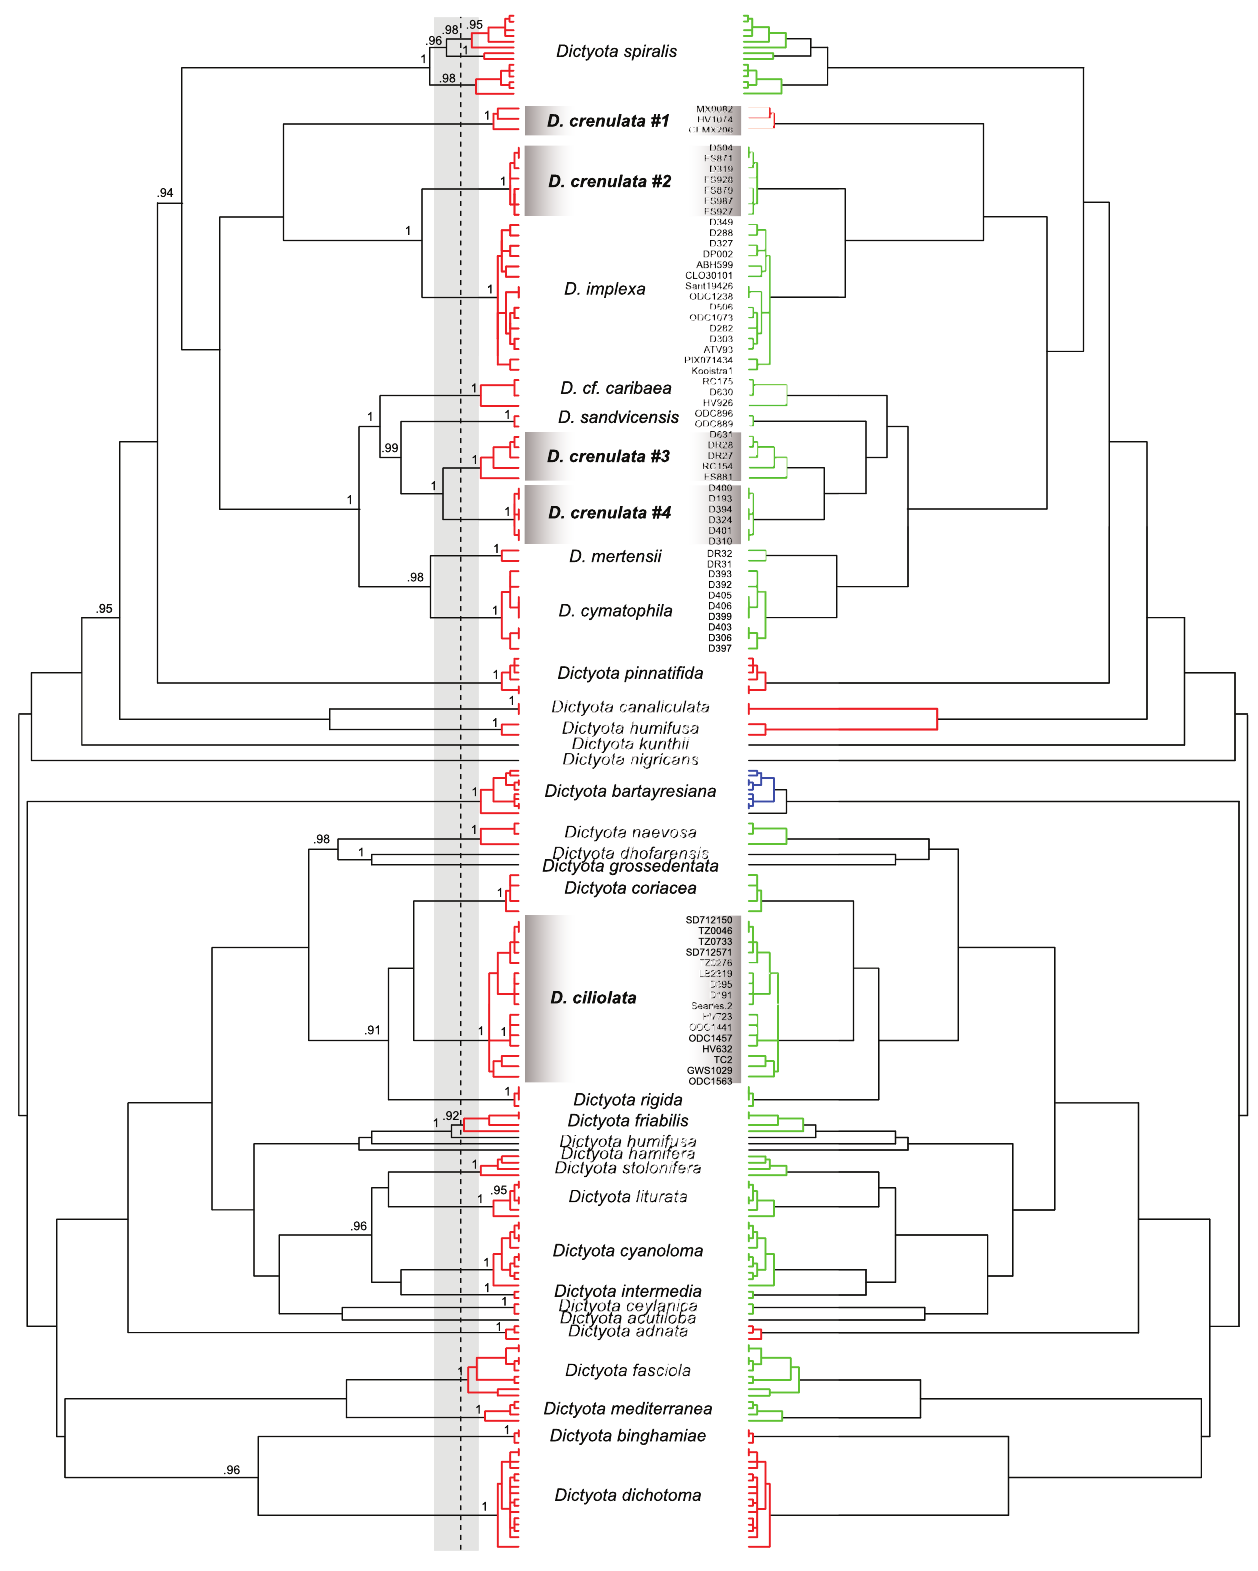
Figure 1. Ultrametric tree of Dictyota based on a Bayesian analysis of 184 psb A sequence data. Divergence times were estimated under a relaxed molecular clock using an uncorrelated lognormal (UCLN) model in BEAST. The dotted vertical line indicates the maximum likelihood transition point of the switch in branching rates, as estimated by a general mixed Yule-coalescent (GMYC) model. The GMYC analysis was performed using a single threshold (left) and multiple thresholds (right). doi:10.1371/journal.pone.0030813.g001 PLoS ONE | www.plosone.org